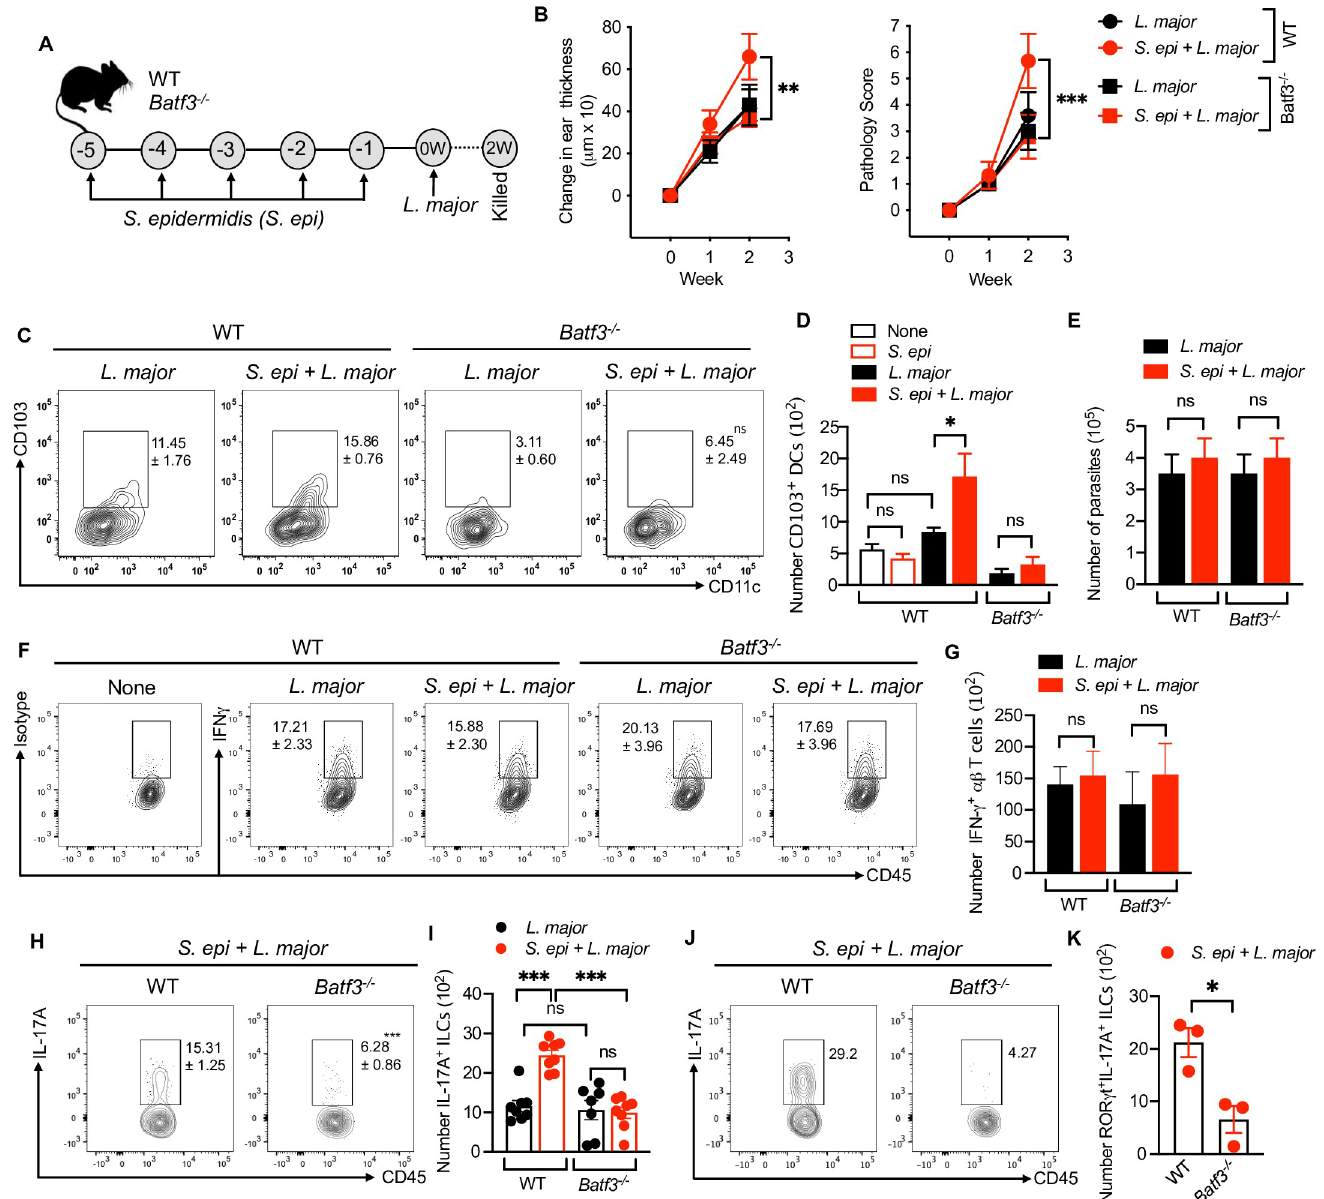
Fig 4. S . epidermidis dependent IL-17A + ILCs and inflammatory responses require CD103 + DCs. (A) Schematic representation of S . epi and L . major treatment protocol in WT and Batf3 -/- mice. (B) Ear thickness measurement and pathology score in WT and Batf3 - /- mice colonized with S . epi or uncolonized prior to L . major infection at week one and two. (C,D) Percent and number of CD103 + DCs at week two in WT and Batf3 - /- mice colonized with S . epi or uncolonized prior to L . major infection at week two. (E) L . major parasite load in WT and Batf3 - /- mice colonized with S . epi or uncolonized prior to L . major infection at week two. (F,G) Percent and number of IFN- γ + αβ T cells in WT and Batf3 - /- mice colonized with S . epi or uncolonized prior to L . major infection at week two. (H,I) Percent and number of IL-17A + ILCs in WT and Batf3 - /- mice colonized with S . epi or uncolonized prior to L . major infection at week two. (J,K) Percent and number of ROR γ t + IL-17A + ILCs in the skin of S . epi colonized and L . major infected WT and Batf3 -/- mice at week two. Number within the flow plot show percent of CD103 + CD11c + (C), IFN- γ + (F) and IL-17A + (H,J) cells with SEM. Data are from two experiments with a total of six to eight mice in each group (C,D,F,G,H,I) or from one experiment representative of two with five mice in each group (B,E). Statistical comparison with in the flow plot in C is with L . major group of Batf3 -/- mice. Error bars shows SEM (D,E,G,I,J,K) or SD (B). Two-tailed unpaired Student’s t-test with Welch’s correction or one-way ANOVA with Tukey’s multiple comparison analysis (D,I). ns, not significant; � p < 0.05, �� p < 0.01, ��� p < 0.001.